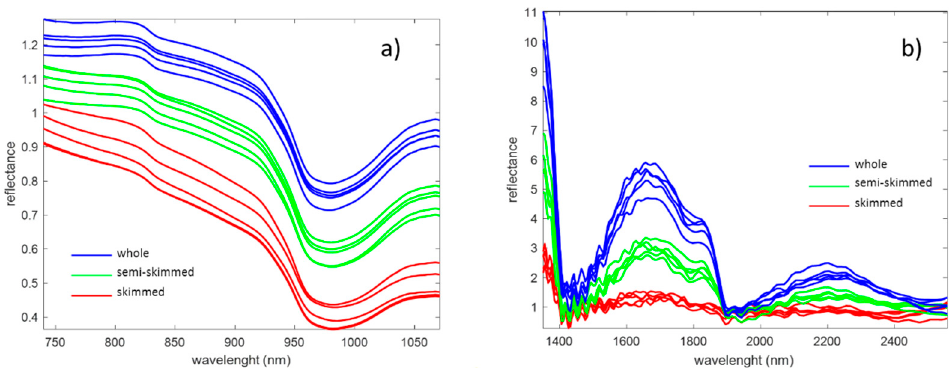
Figure 1. Milk spectra recorded using ( a ) SCiO and ( b ) NeoSpectra.